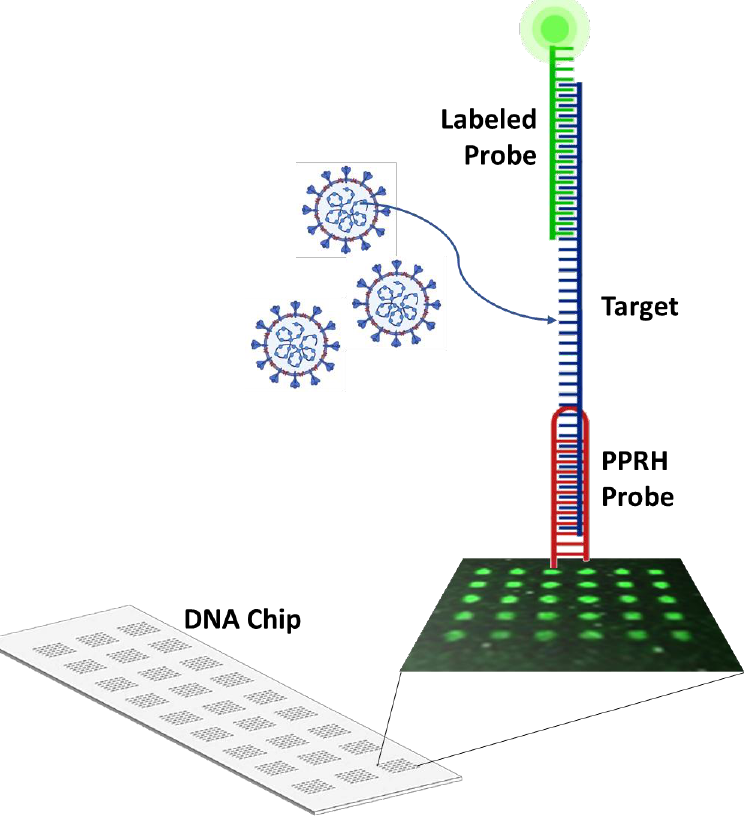
Figure 3. Scheme of the microarray system developed to validate the CC pairs designed for detecting SARS-CoV-2 viral RNA. It comprises a glass surface onto which DNA capture probes (PPRH or duplex) are chemically bounded. These capture probes printed on the glass slide hybridize selectively with the corresponding synthetic target and this binding is reported through the addition of a second probe, which allows the detection since it is coupled to a fluorophore. Thus, the principle of the system is based on the complementarity base pairing between the probes and the corresponding target nucleotide